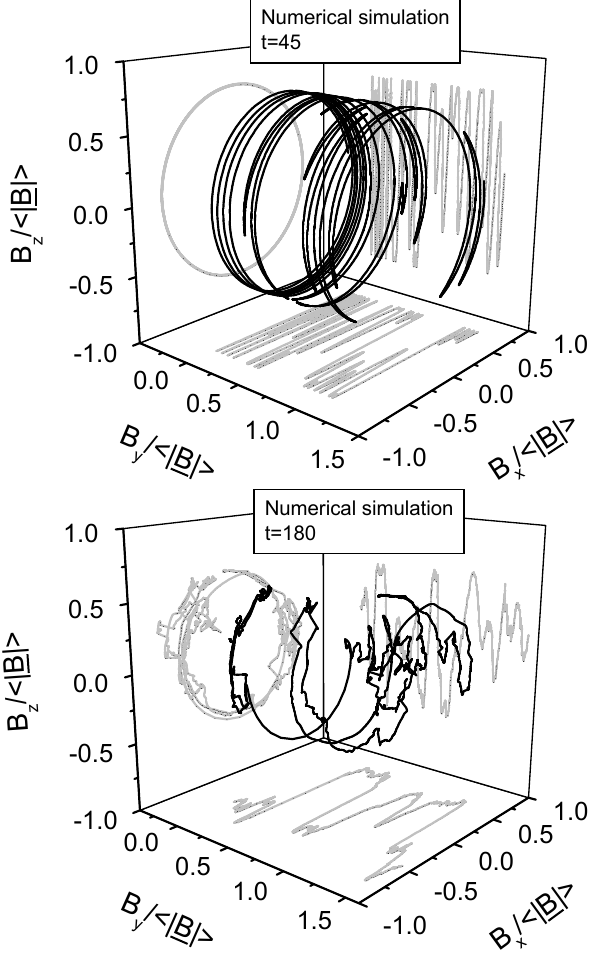
Fig. 17. The top panel of the figure refers to the results of the numer- ical simulations of parametric instability at time t = t 1 = 45 τ A , while the bottom panel refers to the the results at time t = t 2 = 180 τ A . Each point of both plots represents the location of the tip of the magnetic field vector in a point of the simulation domain, in the same format of Fig. 2, which the present figure should be compared with. The difference in the shape of the plots, cylindrical for this figure, spher- ical for Fig. 2, is explained in the text. Also in this case, the sim- ulated data at t = t 1 , corresponding to the real data at 0.3AU, have a more uniform distribution on the cylindrical surface, whilst the data at t = t 2 (to compare with real data at 0.9AU) show long jumps, followed by small amplitude oscillations around the new values.